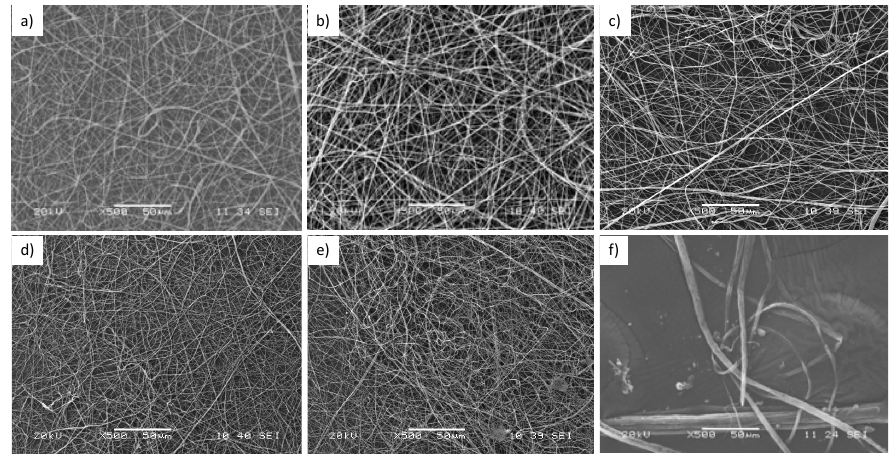
Figure 3. Effect of Pc PAL loading (w/w%, enzyme:dry mass of PLA) on the morphology of PLA nanofibers ( a ) without, and ( b ) with 0.05%, ( c ) 0.10%, ( d ) 0.15%, ( e ) 0.2% and ( f ) 0.25% of Pc PAL.